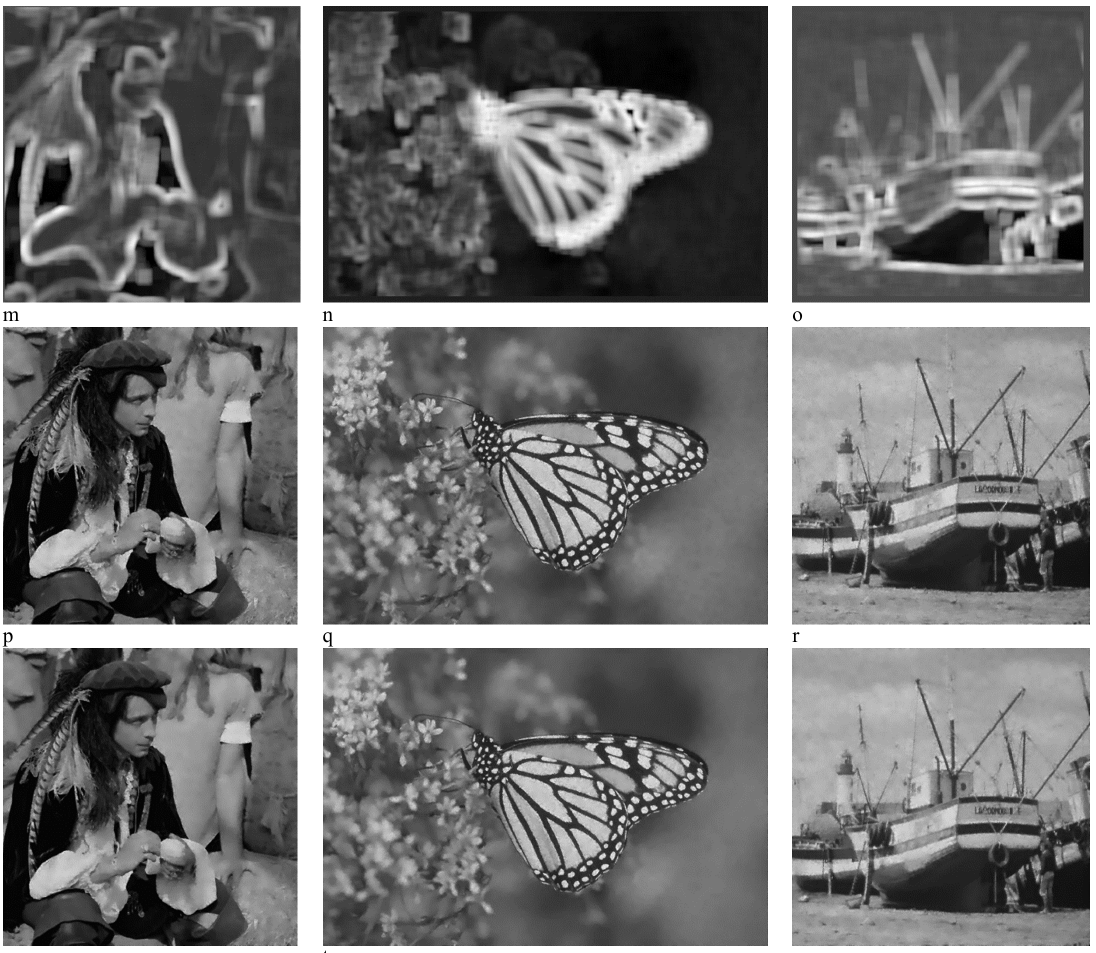
Figure 8. Proposed filter steps. ( a–c ) Noisy image; ( d–f ) Applying the EAWF; ( g–i ) DOV with window = (5 × 5); ( j–l ) Applying the EGF for the first time; ( m–o ) CV’ with window= (21 × 21); ( p–r ) Applying the EGF for the second time; ( s–u ) Final outcome of image despeckling.